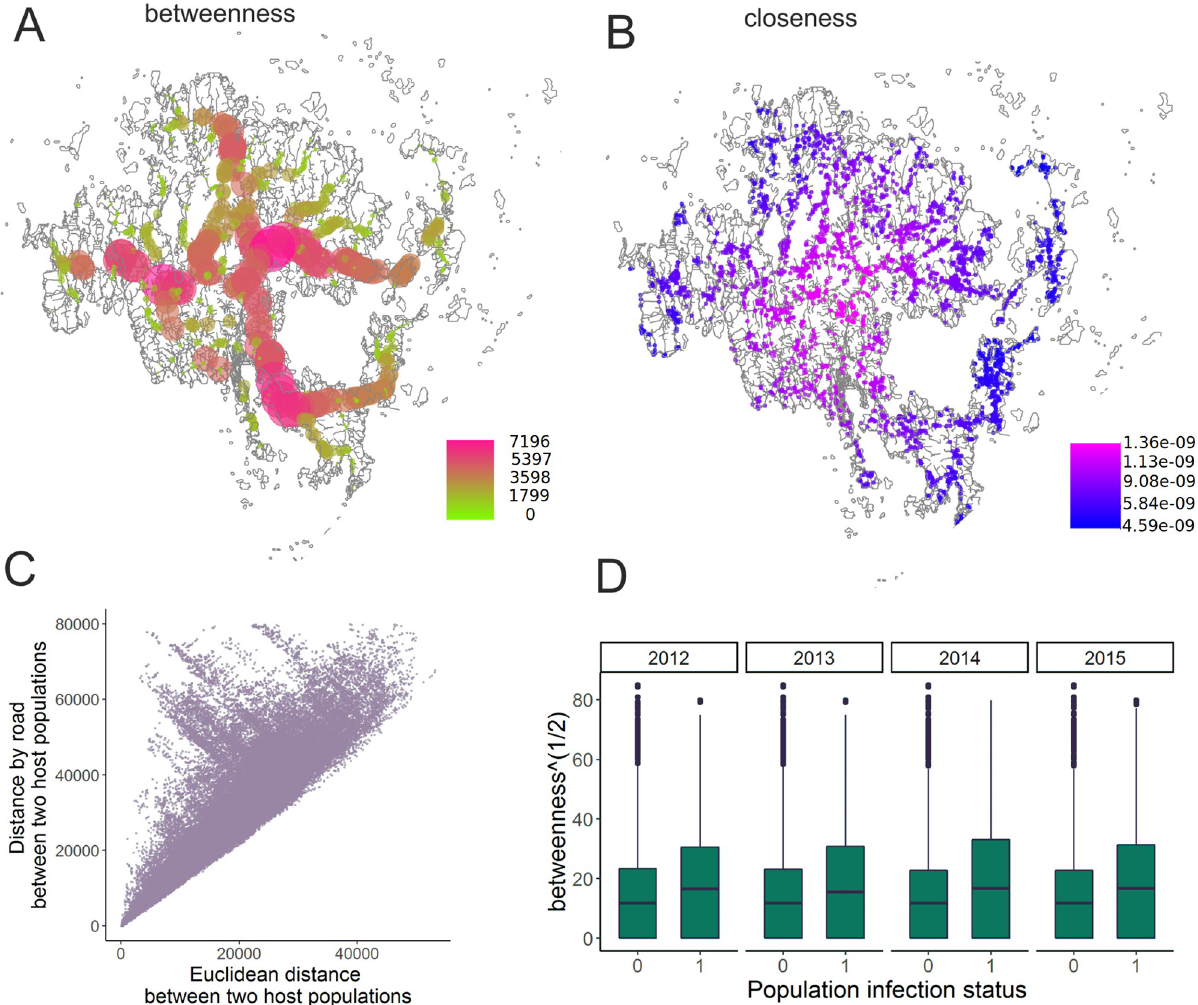
Fig 4. The two computed centrality measures, betweenness (A) and closeness (B), for the considered host populations, computed based on their projection to the closest point in the road network. The correlation between the Euclidean- and shortest distance by road for a random set of pairs of host populations (C) and the relationship between the computed betweenness summary-statistic and the presence and absence of pathogen in different years (D). The roadmaps in the background were created using data produced by National Land Survey of